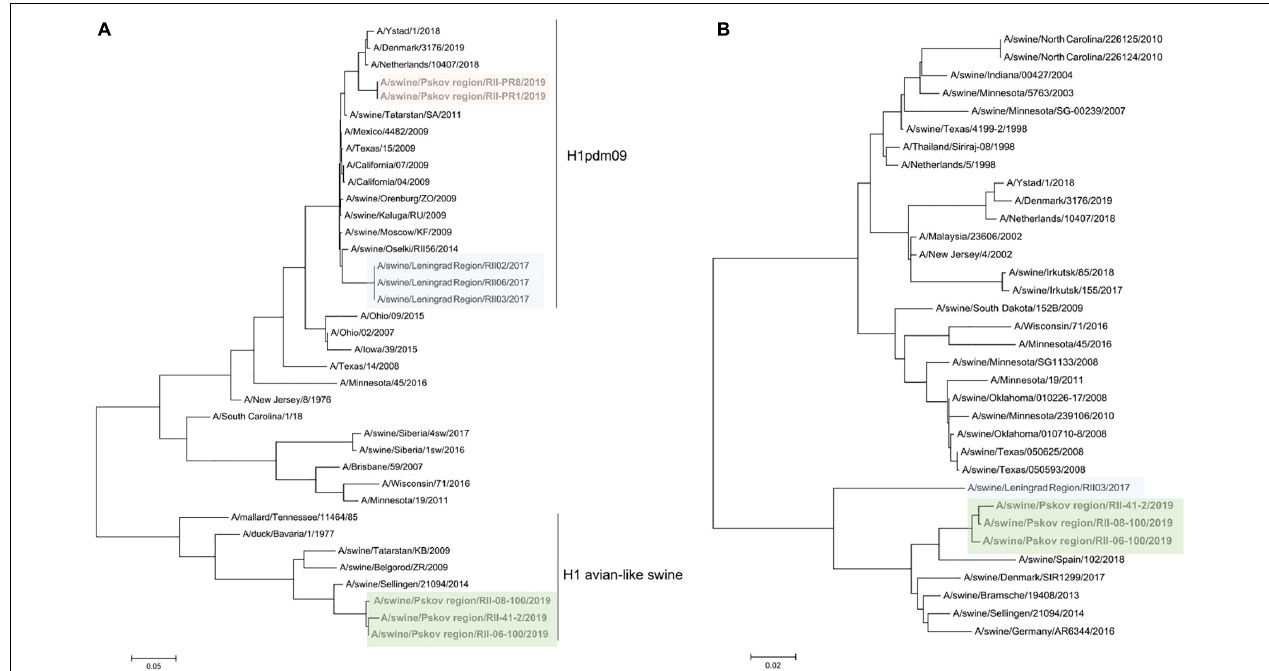
FIGURE 4 | Maximum likelihood tree for swine influenza A HA (A) and NA (B) of reassortant H1N2 viruses isolated in 2017 and 2019. H1pdm09-like HA are shaded in pink and blue, avian-like H1 are shaded in green.